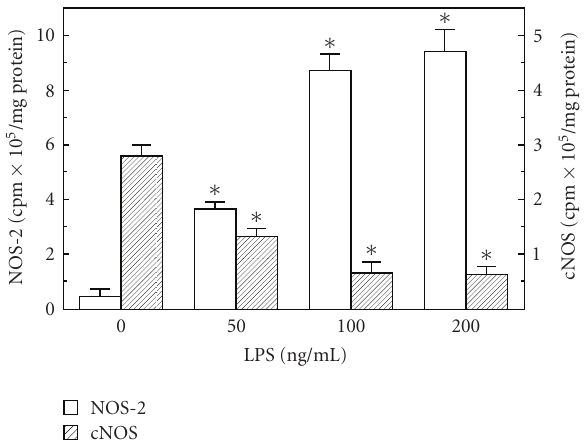
Figure 2: E ff ect of H. pylori LPS on the expression of inducible (NOS-2) and constitutive (cNOS) nitric oxide synthase activities in rat gastric mucosal cells. The cells were treated with the indicated concentrations of the LPS and incubated for 16 h. Values represent the means ± SD of five experiments. ∗ P < . 05 compared with that of control (LPS,